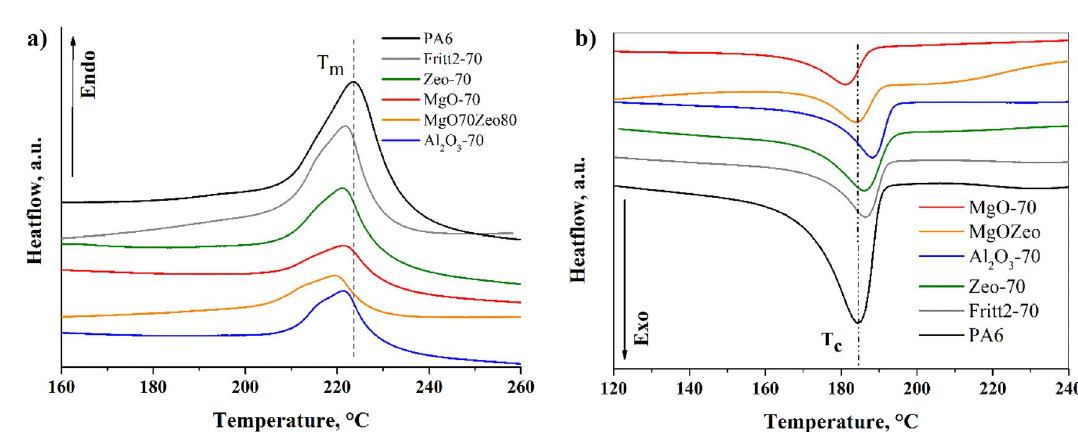
Figure 4. Dependence of Shore D hardness on weight ( a ) and volume percentage ( b ) for different types of filler in PA6 composites.